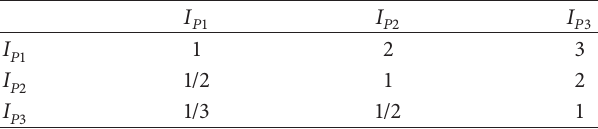
Table 5: Product index judgment matrix of secondary indicators relative to primary